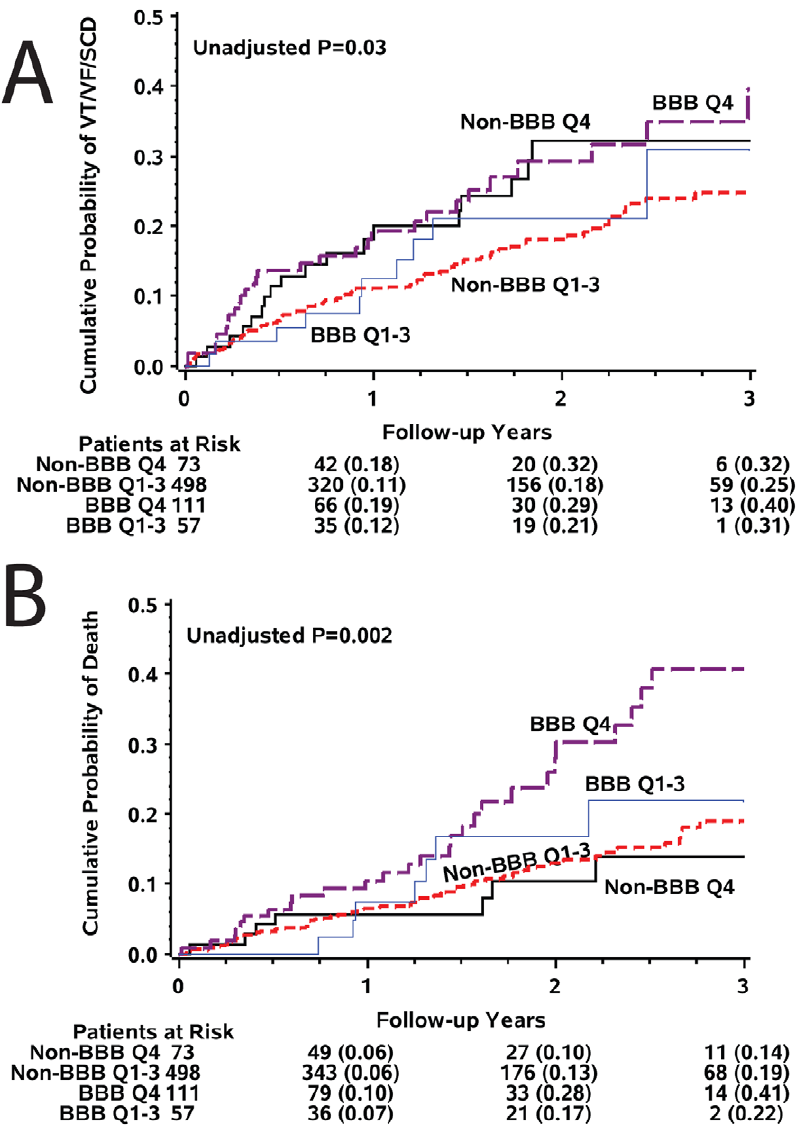
Figure 5. Kaplan-Meier curves for the probability of (A) sudden arrhythmic death, and (B) all-cause mortality in patients with the highest SAI QRST quartile and those with the lower 3 SAI QRST quartiles, by the presence of bundle brunch block.